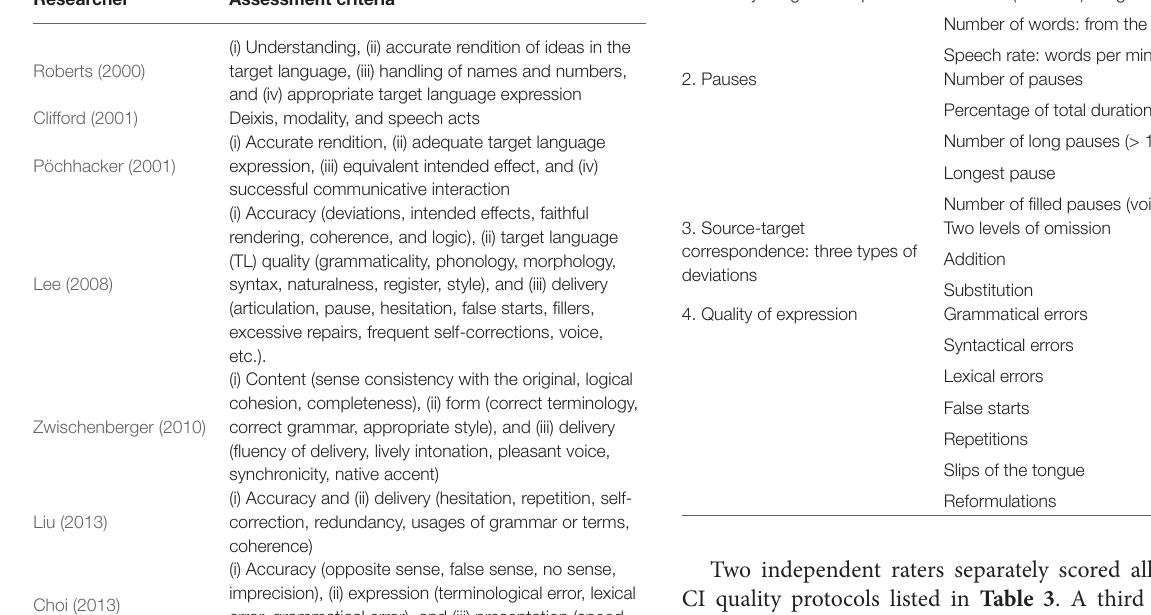
TABLE 1 | Overview of studies on CI quality. Researcher